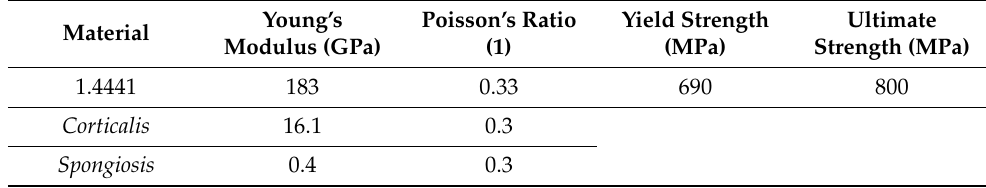
Table 1. Material models of bone and stainless steel.